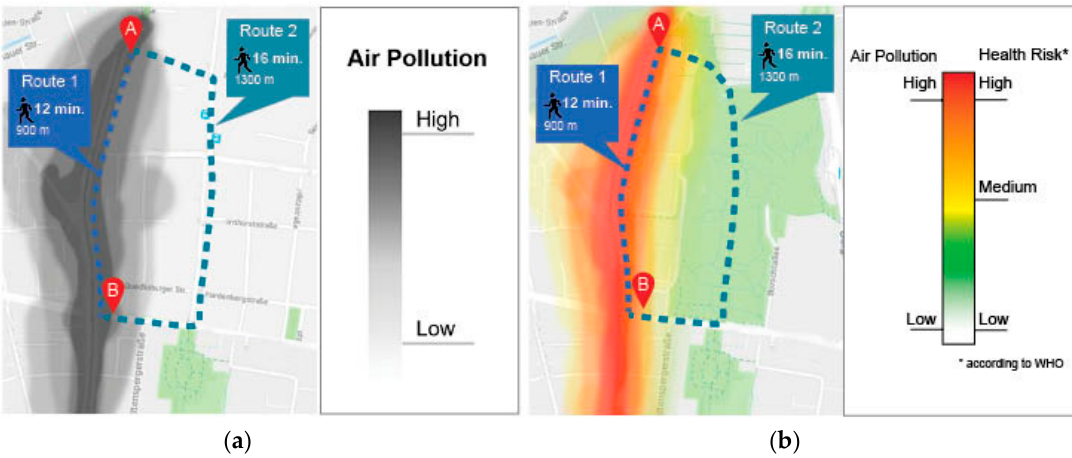
Figure 1. Two examples of the twelve conditions as part of the experimental manipulation in the study: ( a ) a map that that did not provide a green-space option; absence of both traffic light color-coding and the WHO interpretation; ( b ) a map that made a green-option available; presence of both traffic light color-coding and the WHO interpretation.